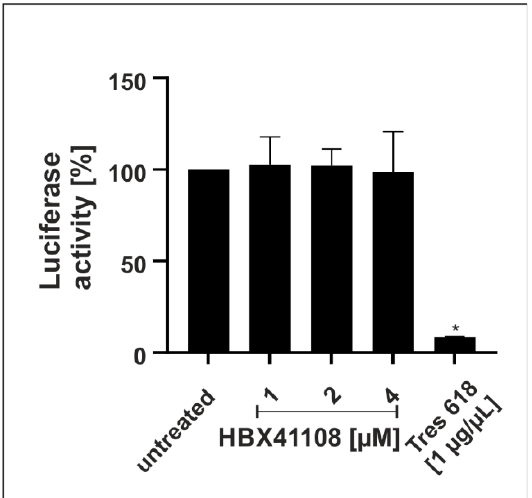
Figure 7. Effect of HBX41108 on SARS-CoV-2-spike-driven entry. Quantitative analysis of Luciferase activity following infection of 293T-ACE2 with Alpha-spiked lentiviral pseudoparticles. Particles were treated with interventions prior to infection for 1 h. The efficiency of infection in cell lysates was determined by measuring the luciferase activity 48 h post infection. Bars represent mean values of three independent experiments ± SD. Statistical analysis was performed using a multiple comparison Kruskal–Wallis test (Anova) followed by Dunn’s post hoc test (* p < 0.05). To control for potential unspecific effects of drug treatment on cell viability in the pseudoviral assay, water-soluble tetrazolium salt WST-1 assays were performed in uninfected 293T-ACE2 cells 48 h after treatment. Concentrations of the interventions,